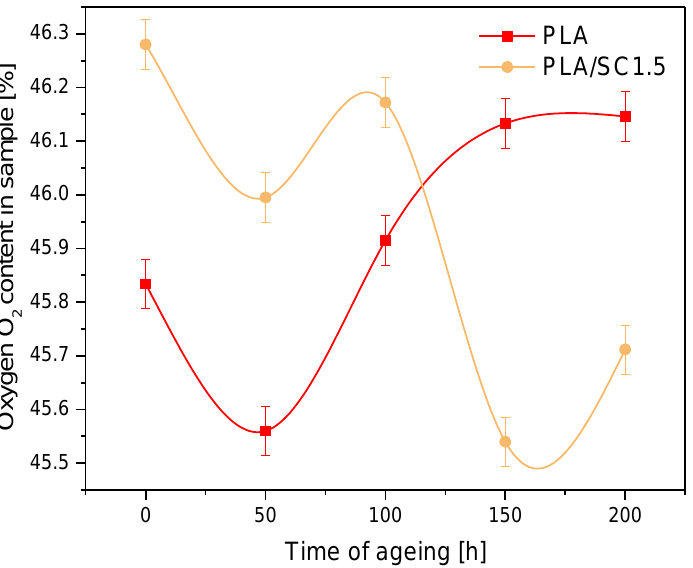
Figure 2. Oxygen content in PLA and PLA/Succinic acid (SC) 1.5 samples during solar aging.